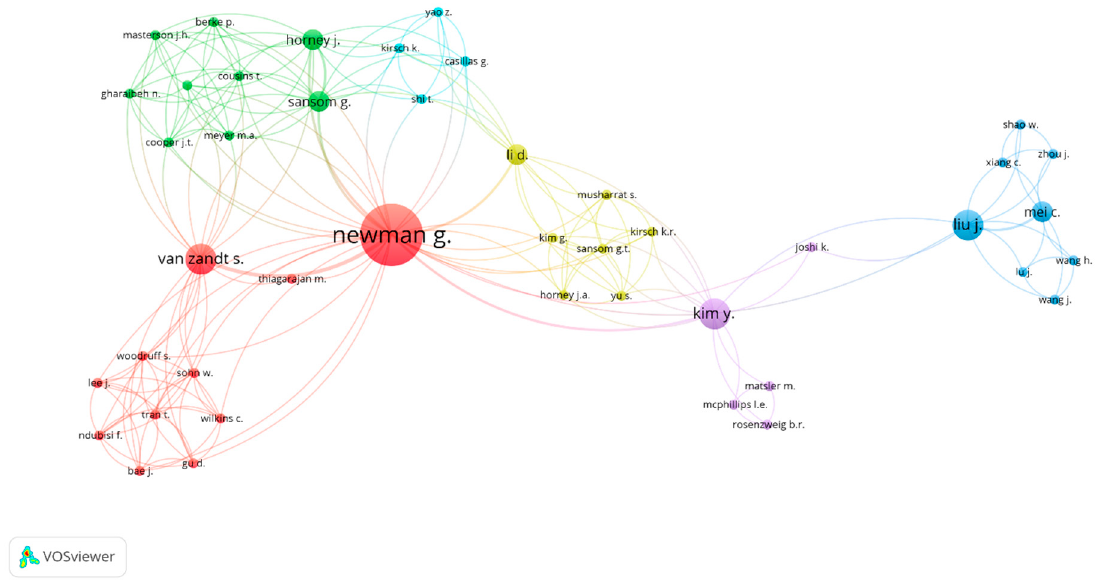
Figure 2. Clusters of authors’ connections.